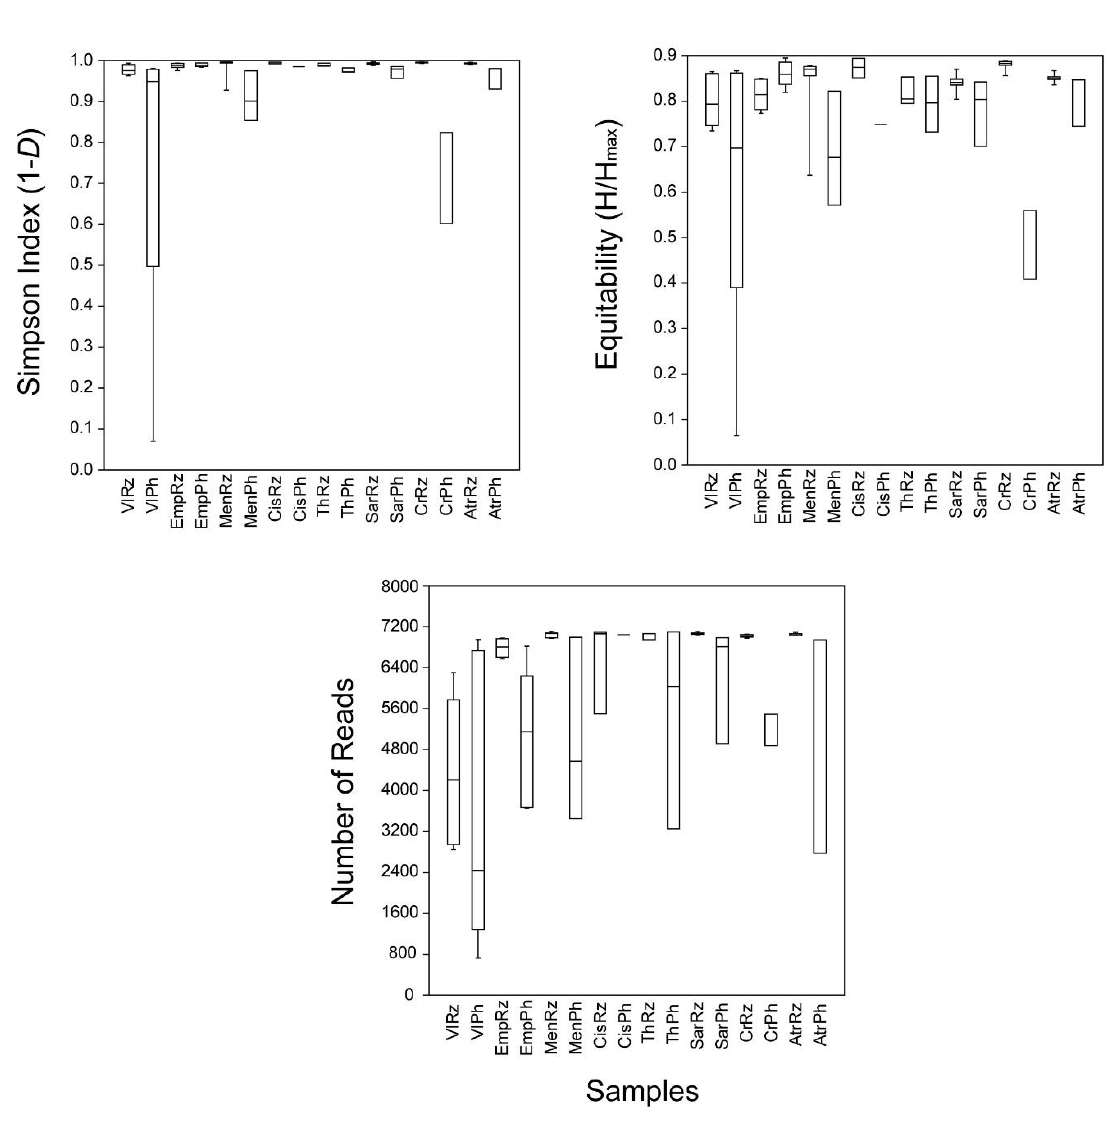
Figure 2. Boxplots of number of OTUs, ratio of observed:expected number of OTUs, the Simpson (1- D ) and Equitability (H / H max ) indexes, and the number of reads in the di ff erent plant samples. Error bars represent standard deviation of sampled individuals in each plant and plant compartment. See Table 1 for coding assignments.